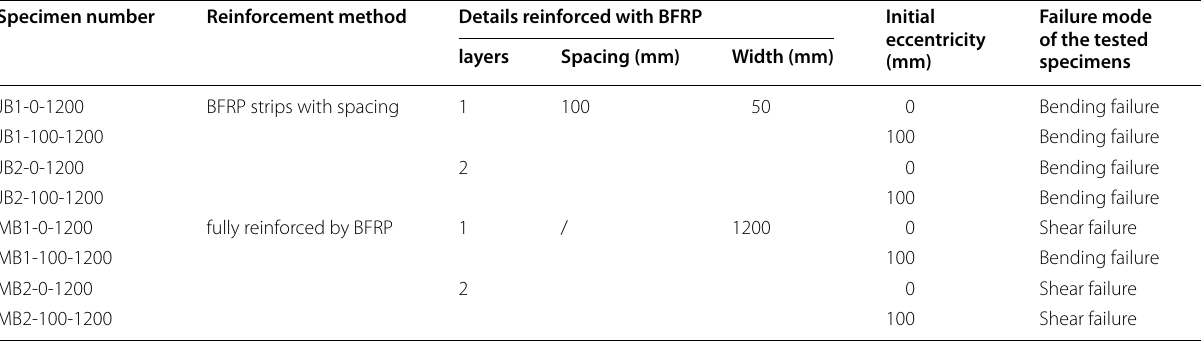
Table 5 Failure mode of the tested specimens Specimen number Reinforcement method Details reinforced with